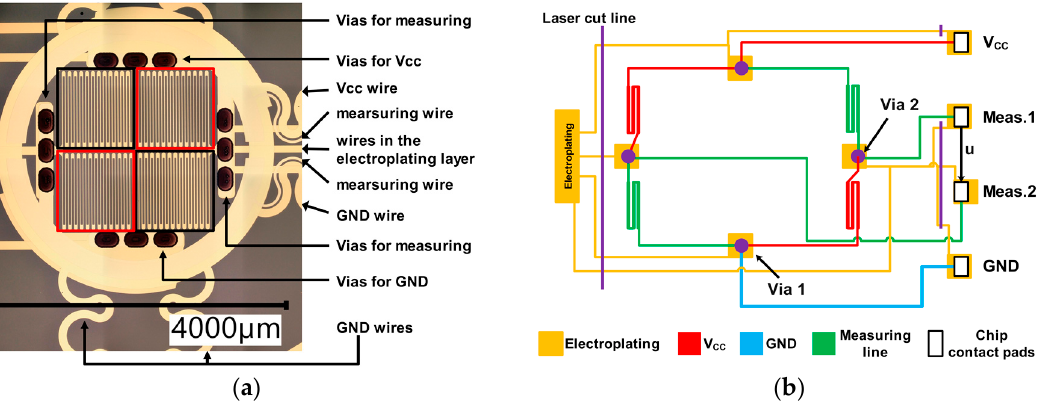
Figure 1. ( a ) Micrograph of a single sensor node. Strain gauges marked with the same color (black or red) are located on the same level within the multilayered device. ( b ) Schematic of the sensor nodes Wheatstone bridge circuit. Also shown are the leads for equipotential connection required during galvanization, which are afterwards cut off with a laser.